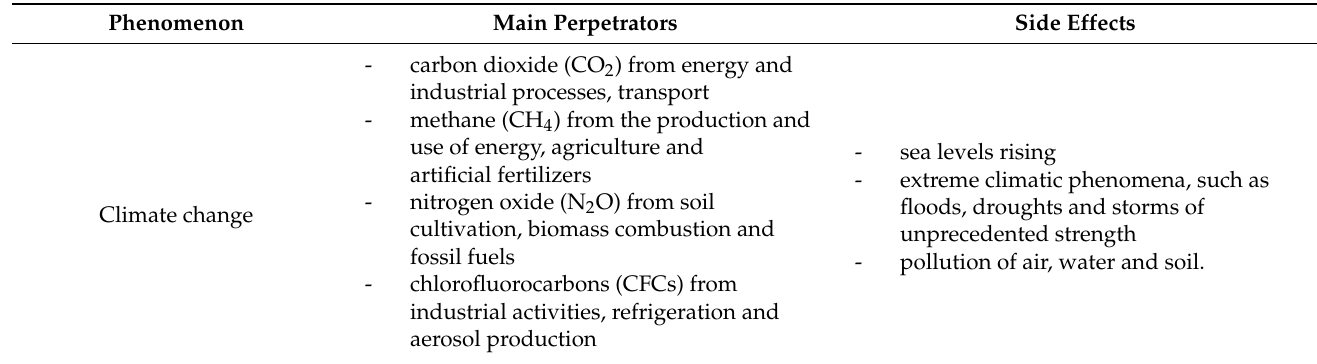
Table 1. Environmental problems: phenomena, perpetrators and effects, reproduced from [17] with the permission of the author. Data were obtained from reference